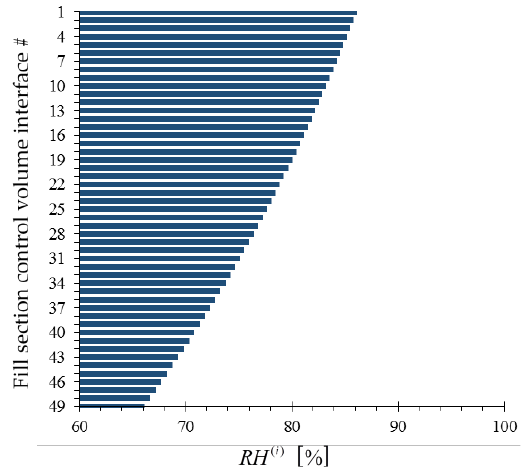
Figure 7. Bar plot of the air relative humidity RH ( i ) , ( i = 1, . . . ,49 ) , at the exit of each control volume along the height of the fill section of the cooling tower.